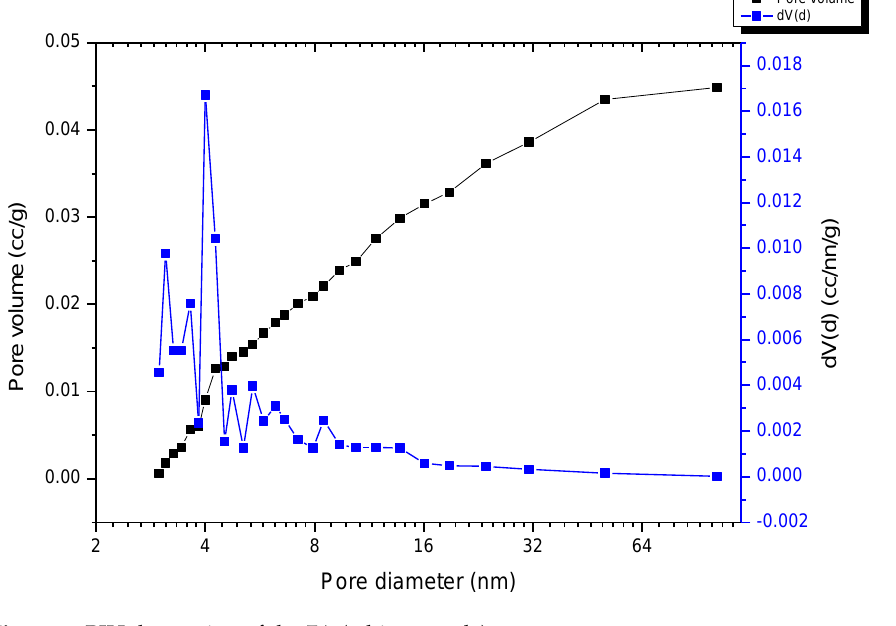
Figure 8. BJH desorption of the 7A (white sample).